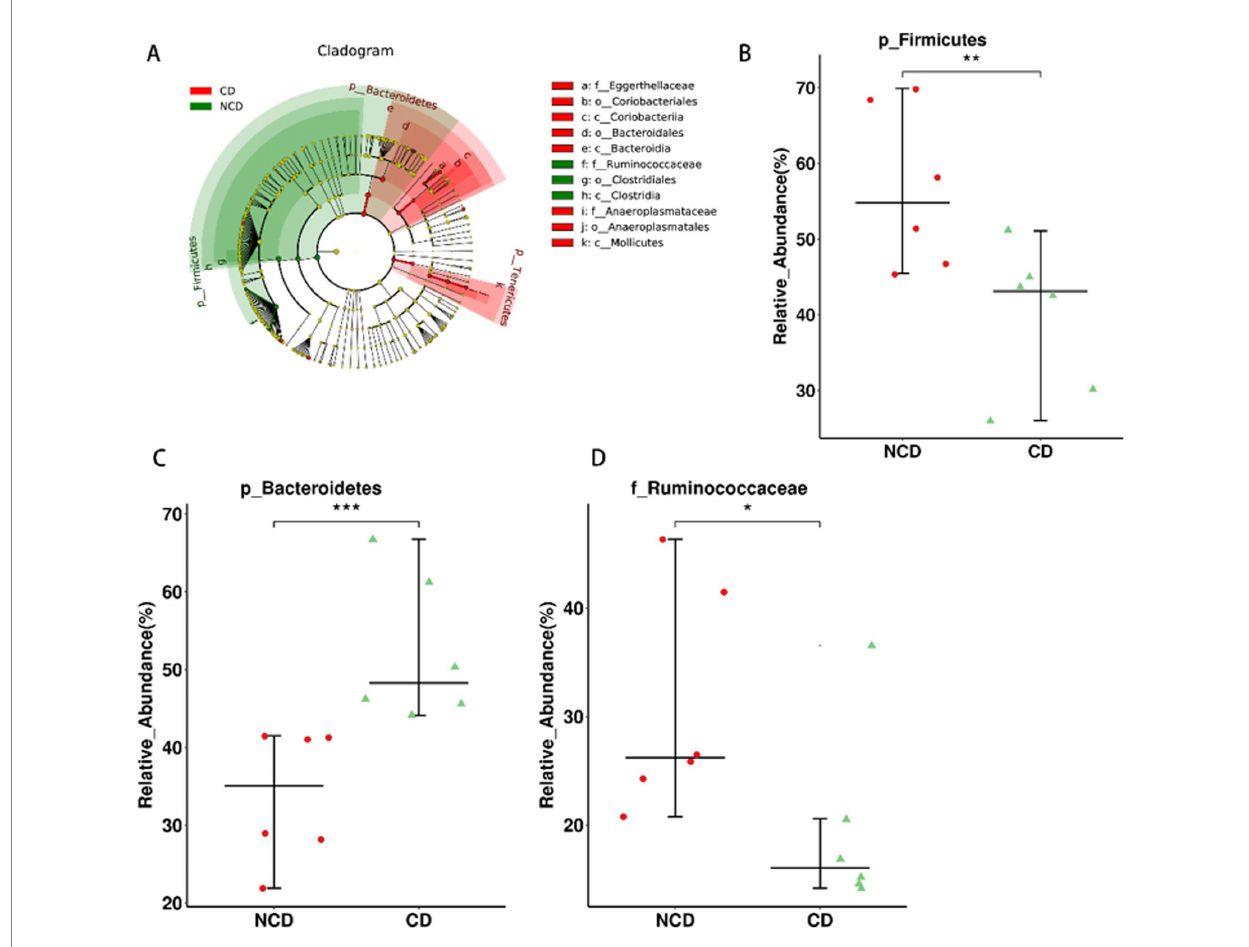
FIGURE 5 The relationship between dysbiosis markers and cognitive dysfunction. (A) Linear discriminant analysis effect size between the Group-CD and Group- NCD groups. (B–D) Relative abundance of gut microbiota at the species level. Data are presented as the mean ± SEM. * p < 0.05, ** p < 0.01, *** p